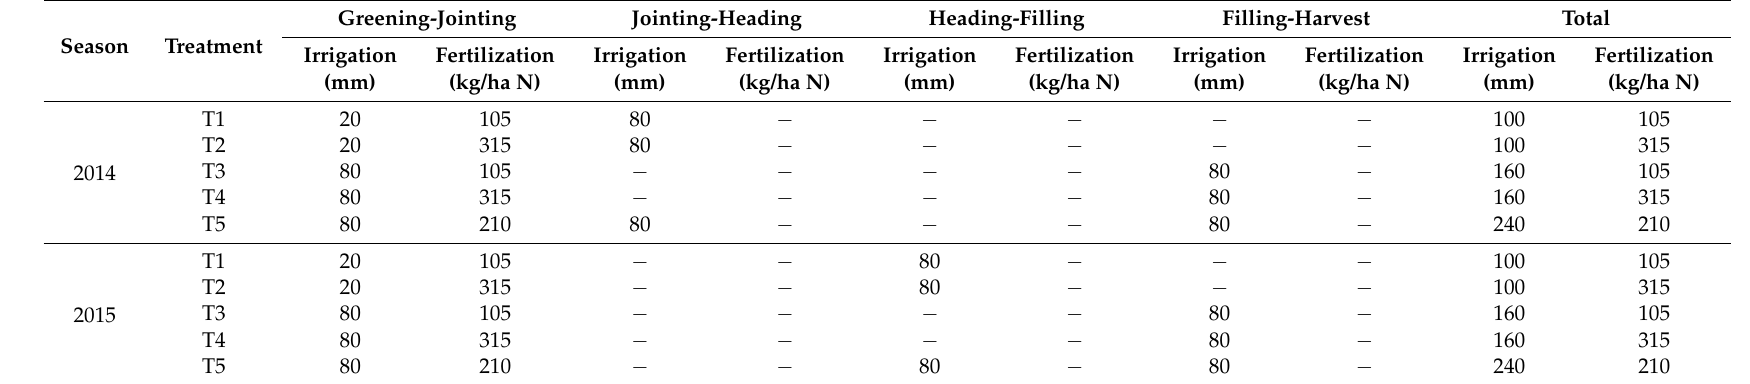
Table 2. Irrigation and fertilization (as urea) schedules for each treatment of the winter wheat during the experimental seasons. Greening-Jointing Season Treatment